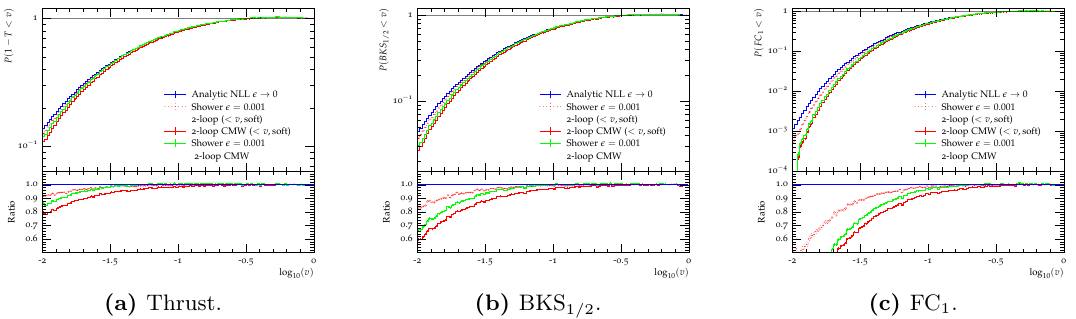
Figure 5 . E(cid:11)ects of replacing 1-loop by 2-loop CMW running of (cid:11) s in the sub-leading terms of the NLL result. The red line is computed by making the replacements only in the soft-enhanced term if (cid:24) < Q 2 v 2 = ( a + b ) , the red dotted line corresponds to not using the CMW scheme in this region.